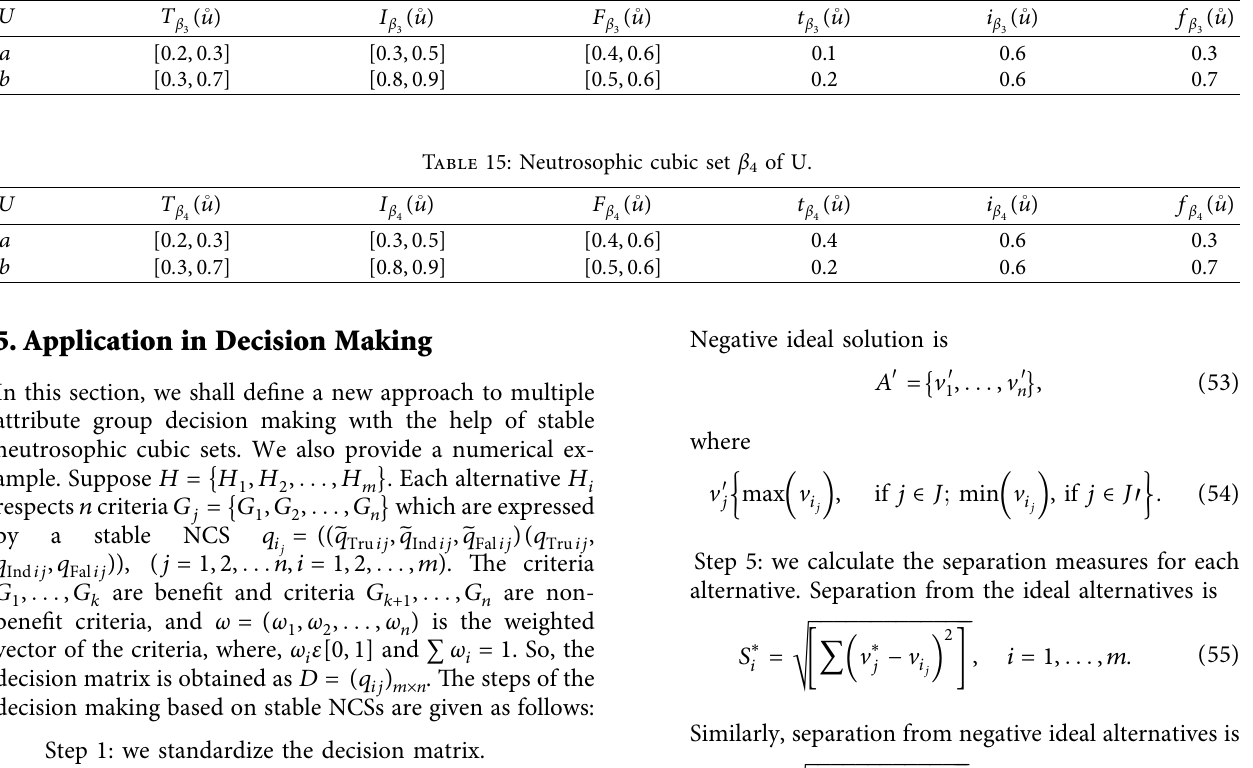
Table 14: Neutrosophic cubic set β